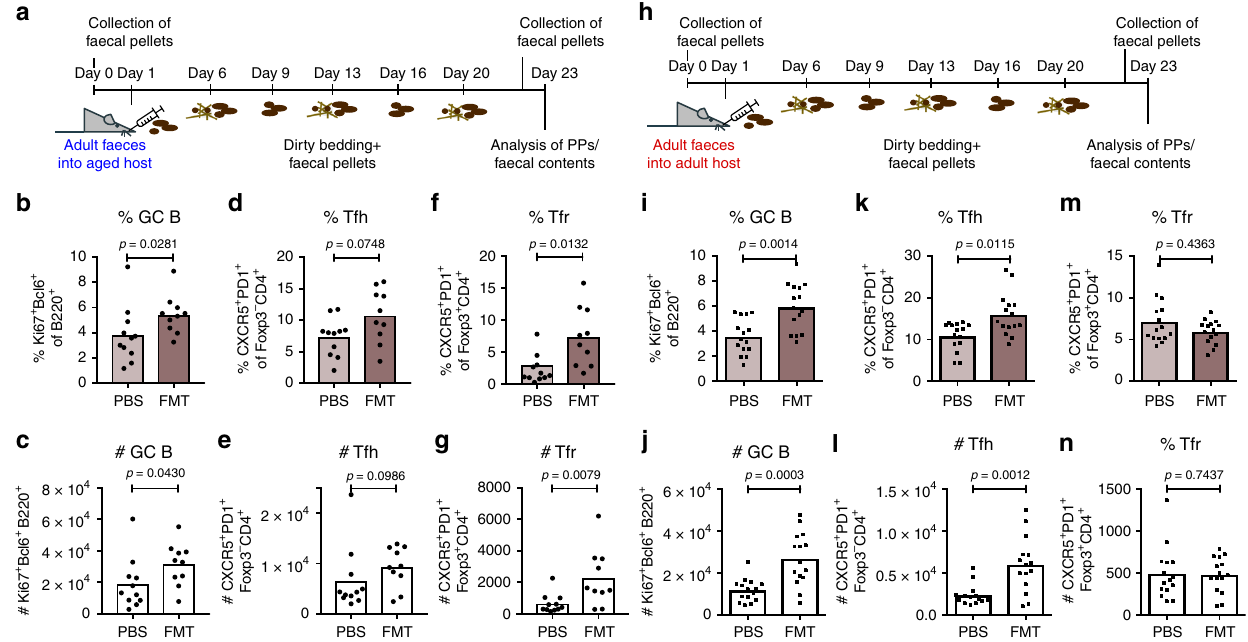
Fig. 5 Faecal microbiota transplantation boosts gut germinal centres irrespective of age directionality. a – g 21-month-old C57BL/6 males were gavaged with faecal pellets from adult, 3-month-old mice. a Experimental outline (created by M. Stebegg) of faecal microbiota transplantation (FMT) where aged C57BL/6 males were given a suspension of faecal pellets from adult C57BL/6 donor mice by oral gavage. The cages of recipient mice were supplemented with fresh faecal pellets and dirty bedding from these donor mice once a week. The percentage and number of B220 + Ki67 + Bcl6 + germinal centre (GC) B cells ( b , c ), CD4 + Foxp3 - CXCR5 + PD-1 + Tfh cells ( d , e ) and CD4 + Foxp3 + CXCR5 + PD-1 + Tfr cells ( f , g ) in Peyer ’ s patches (PPs) as quanti fi ed by fl ow cytometry. h – n 3-month-old C57BL/6 males were gavaged with faecal pellets from aged 21-month-old mice. ( h ) Experimental outline of FMT where adult C57BL/6 males were gavaged with faecal pellets from aged mice. The percentage and number of GC B ( i , j ), Tfh ( k , l ) and Tfr ( m , n ) cells in PPs were quanti fi ed by fl ow cytometry. Bar height corresponds to the mean, each circle represents one biological replicate. Bar plots show the combined results of 2 independent experiments with a total of n = 10 – 15 mice per group. P-values were determined using the Mann-Whitney test in GraphPad Prism6. Source data are provided as a Source Data fi